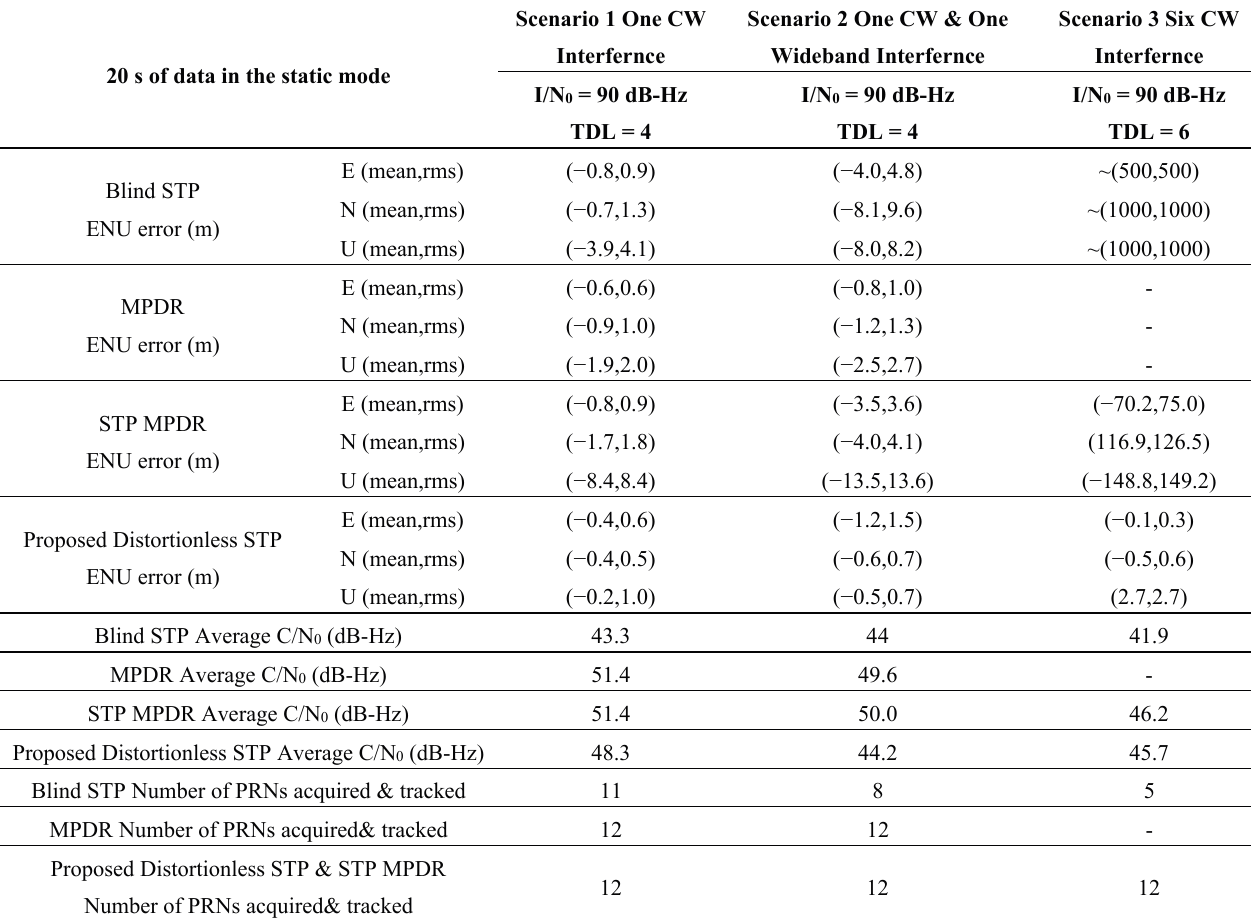
Table 2. Results for different interference